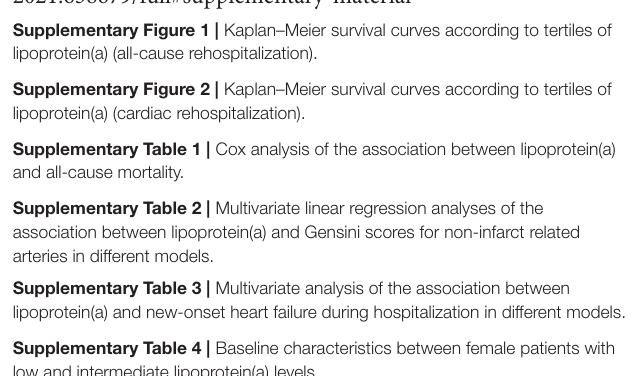
Supplementary Figure 1 | Kaplan–Meier survival curves according to tertiles of lipoprotein(a) (all-cause rehospitalization). Supplementary Figure 2 | Kaplan–Meier survival curves according to tertiles of lipoprotein(a) (cardiac rehospitalization). Supplementary Table 1 | Cox analysis of the association between lipoprotein(a) and all-cause mortality. Supplementary Table 2 | Multivariate linear regression analyses of the association between lipoprotein(a) and Gensini scores for non-infarct related arteries in different